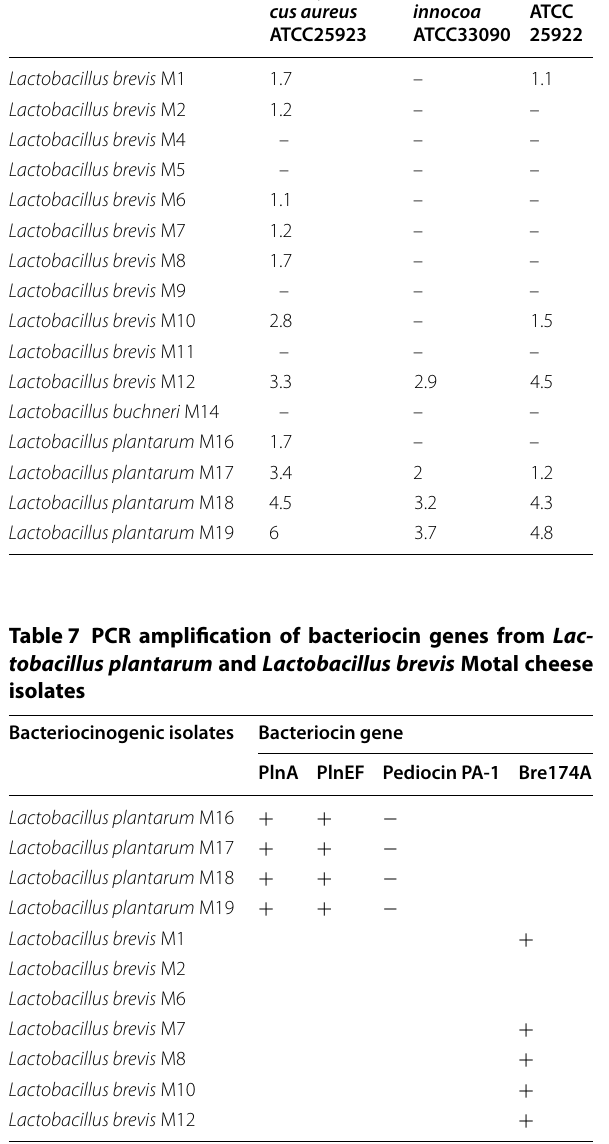
Table 5 Inhibition activity of isolated Lactobacillus genus isolates against indicators using the deferred spot assay Lactobacillus species isolates